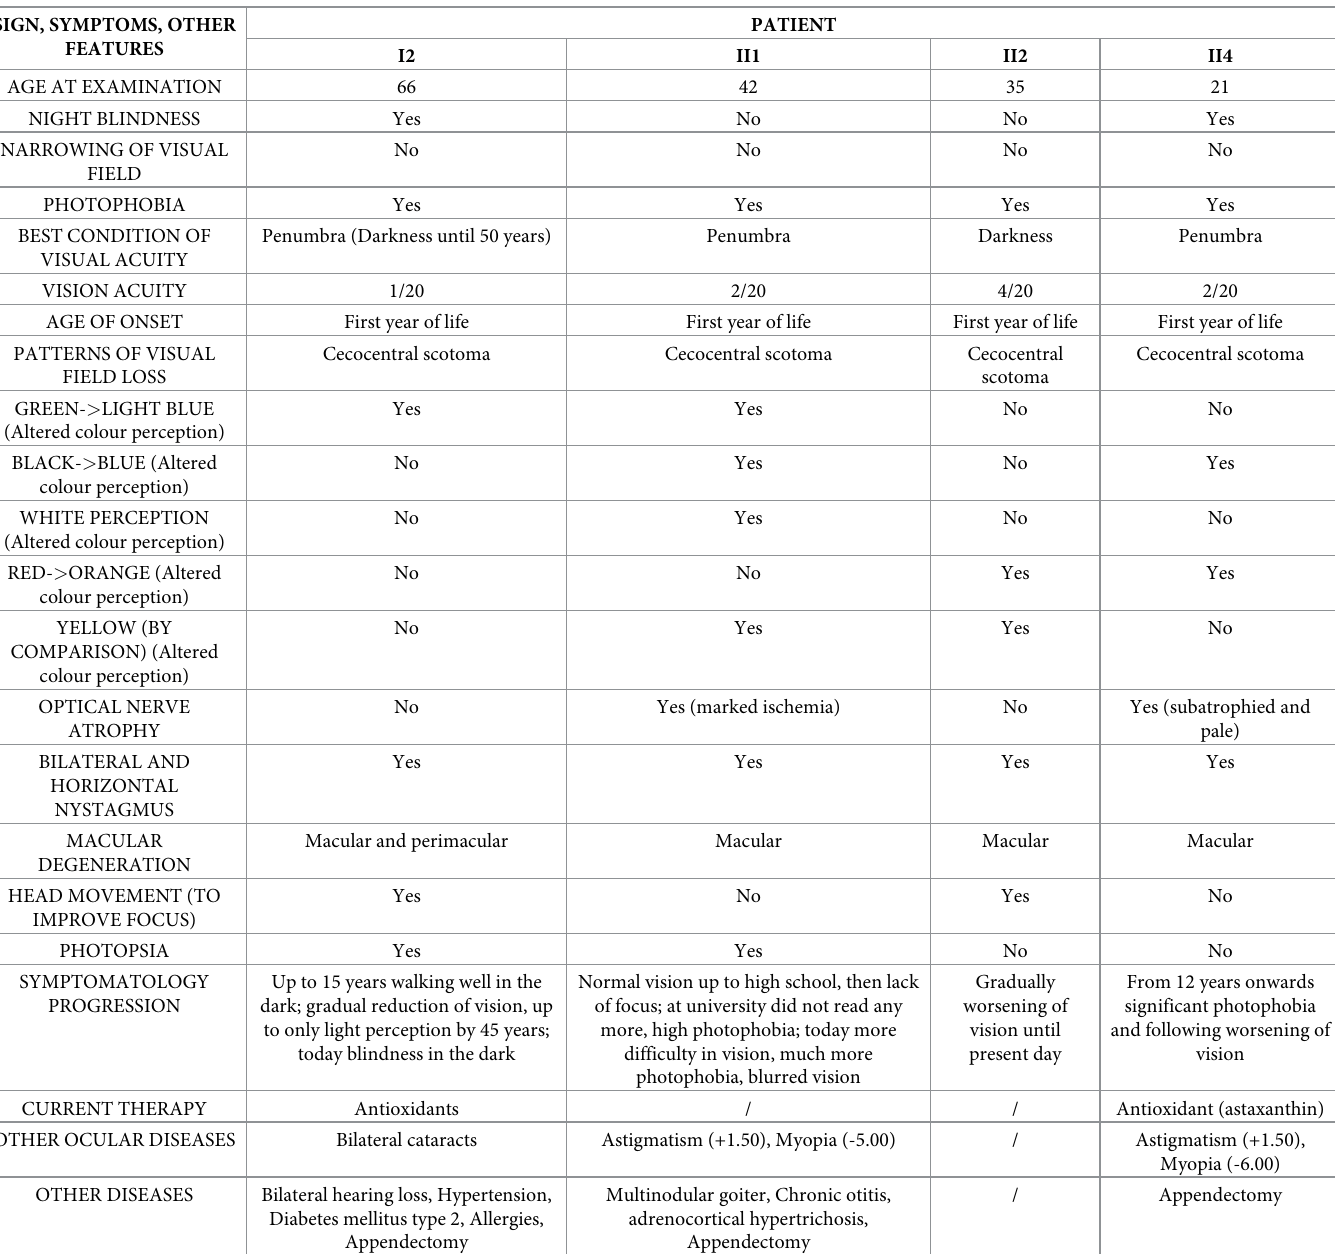
Table 1. Clinical features of the four affected members of the reported Sicilian family. SIGN, SYMPTOMS, OTHER